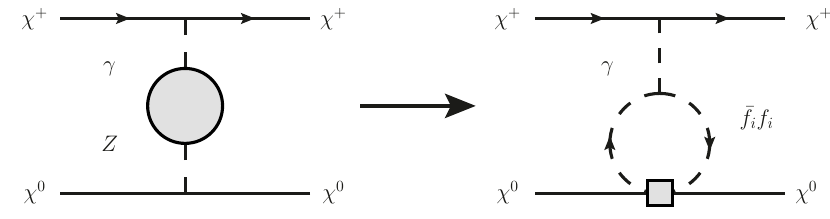
Figure 6 . The relevant one-loop self-energy, that in the large distance, small momentum exchange region, gives the long-range asymptotic (4.21) for δV T 3 T 3 − δV T 3 Y and δV Y Y − δV T 3 Y